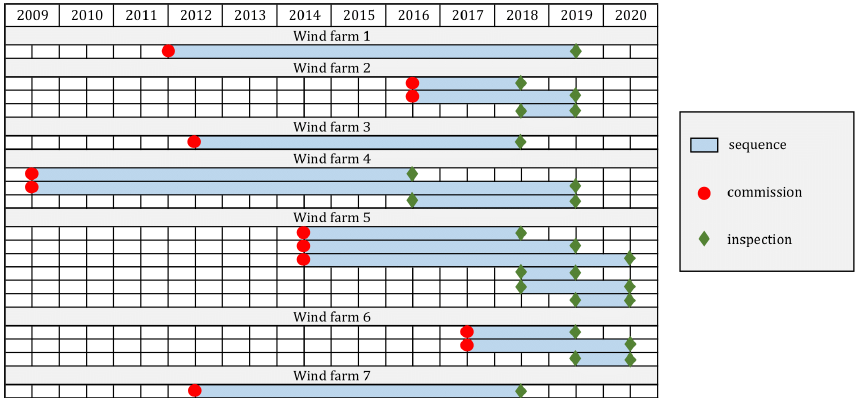
Figure 8. Visualization of all the available data sequences used for generating time-aggregated input and target features. The sequences are shown by light blue blocks and can either start from commission (orange dots) and end with an inspection (green diamonds), or they can start from inspections and also end with